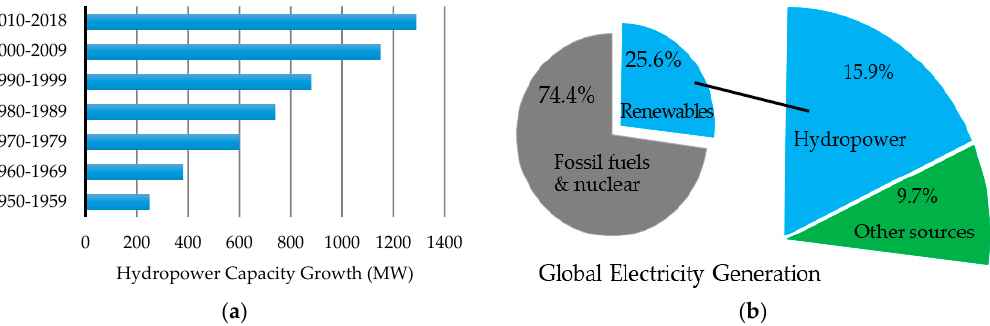
Figure 1. ( a ) Hydropower capacity growth, ( b ) hydropower rank in the global electricity